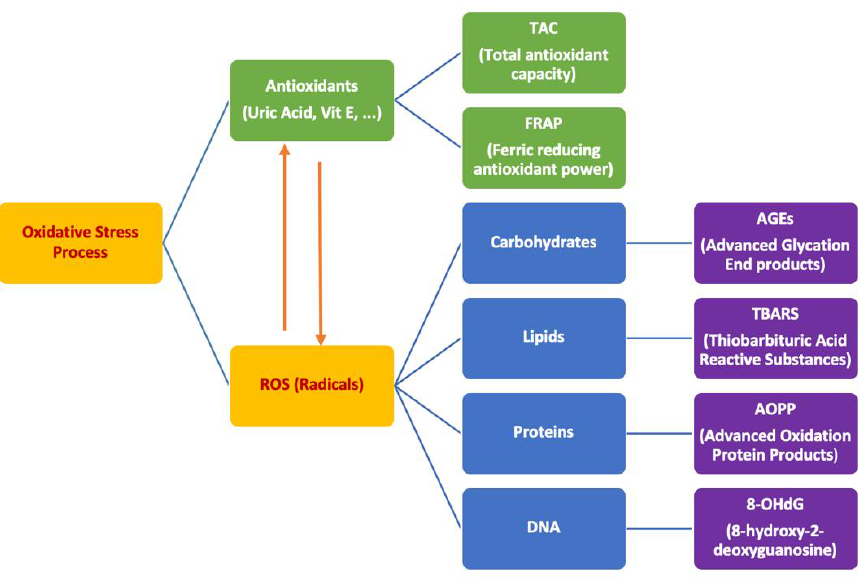
Figure 1. Oxidative stress process and its end product